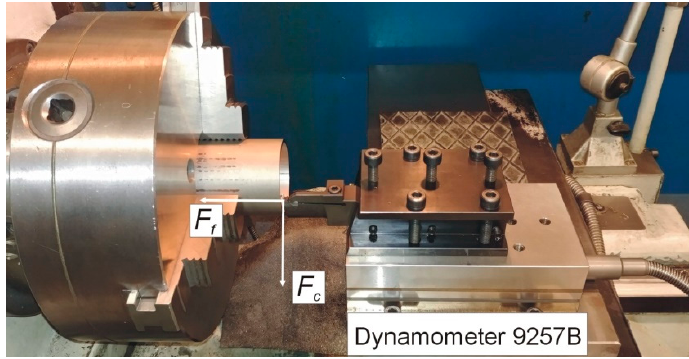
Figure 2. Dynamometer fixing and distribution of forces during the orthogonal turning [36].